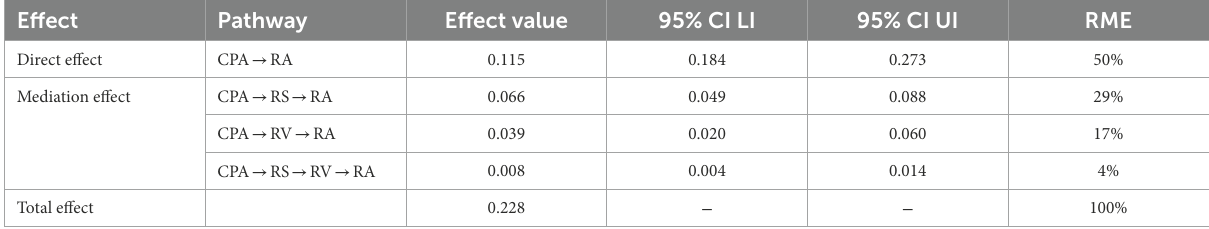
TABLE 4 The chain mediating effect of rejection sensitivity and relational victimization.